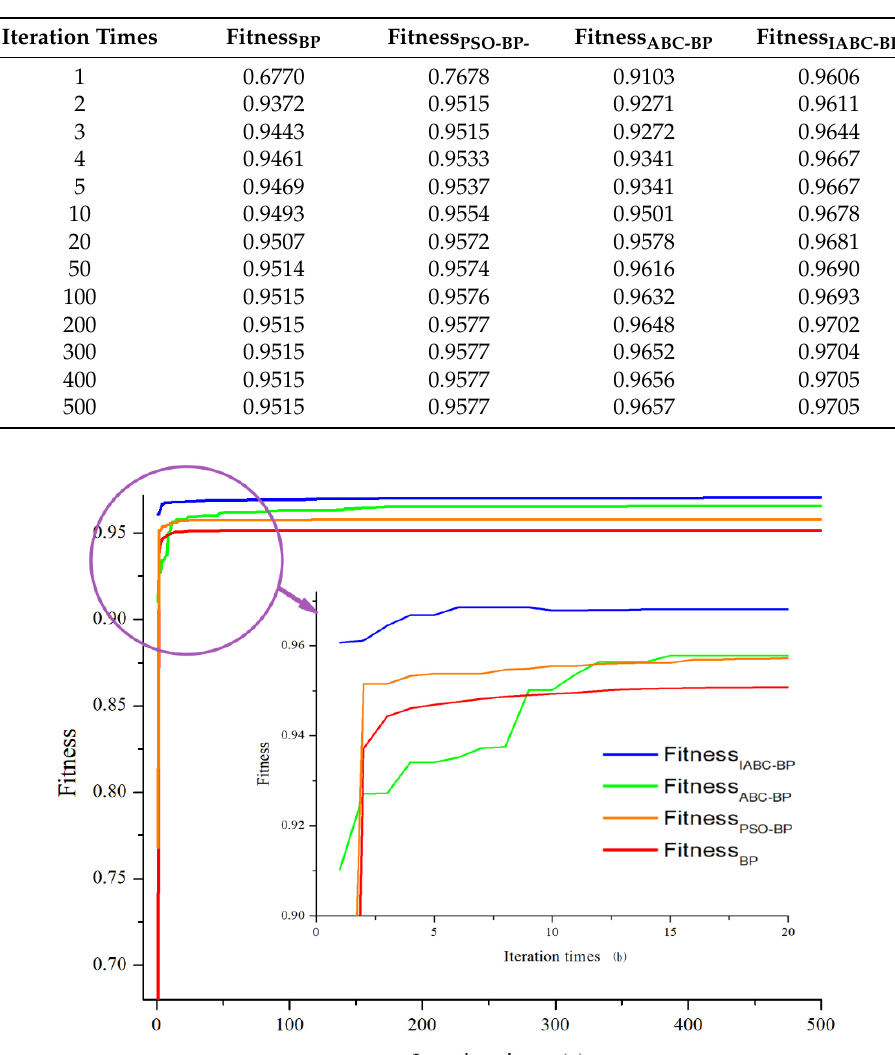
Figure 6. The comparison of fitness among the four models. ( a ) The convergence performance from the first iteration time to the last of four models; ( b ) The convergence performance from the first iteration time to the twentieth iteration time